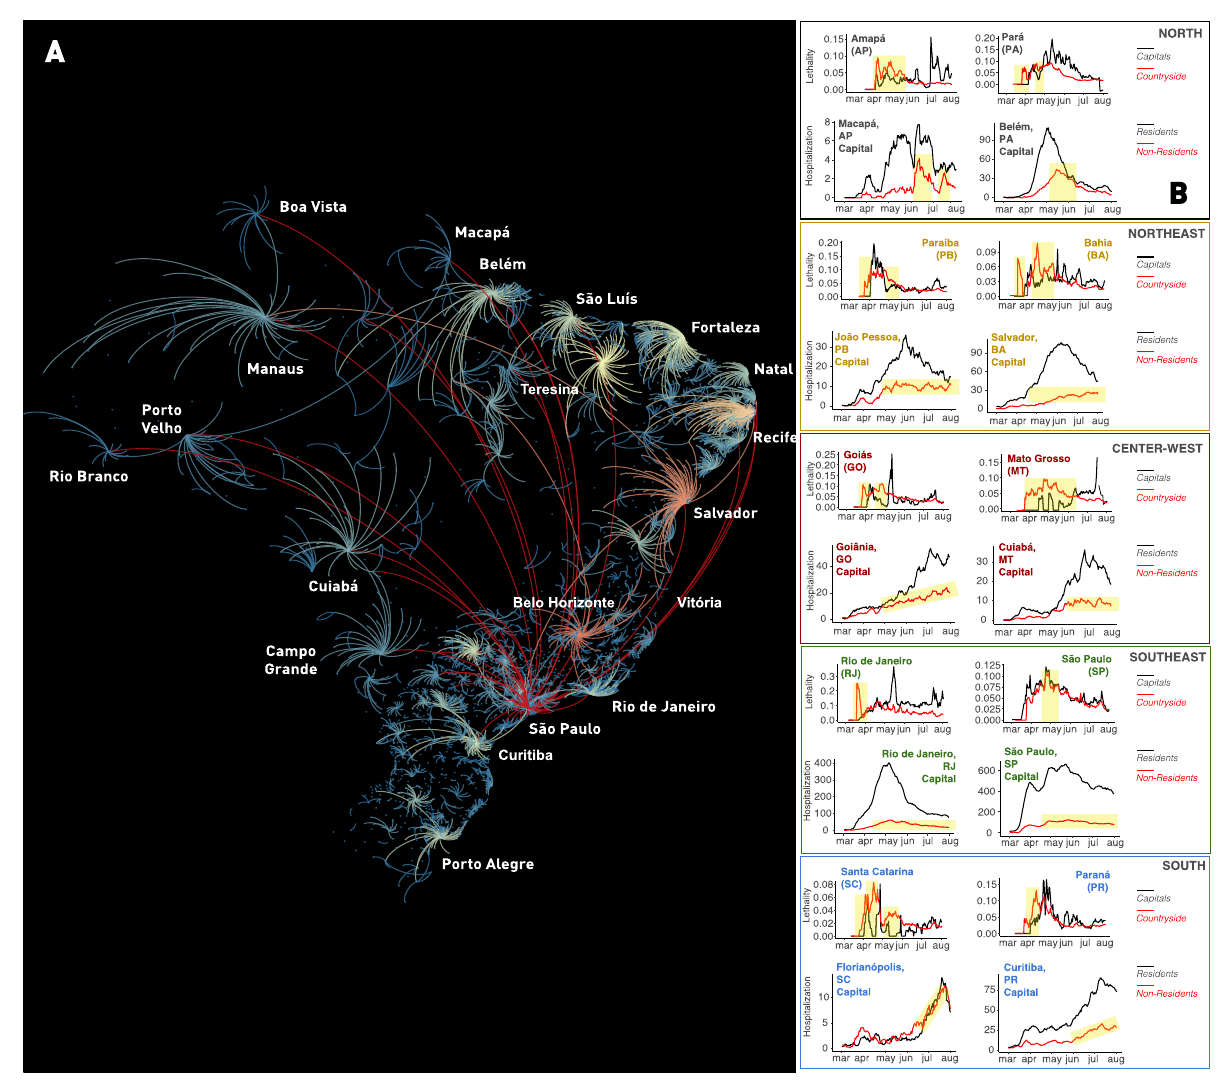
Figure 3. Quantification of the Brazilian “boomerang effect”. ( A ) Representation of all “boomerangs” that occurred around major Brazilian state capitals (see labels for names) and mid-size cities across the whole country. In this map, arcs represent the flow of people from the interior towards the capital. The arc color code represents the number of interior cities that sent severely ill patients to be admitted in hospitals in a capital or mid-size town; red being the highest number of locations, orange and yellow next, while a smaller number of locations are represented in light blue. Most of the flow of people represented in this graph took place through highways. Red arcs likely represent long-distance flow by airplanes. In the Amazon, most of the flow of people towards Manaus occurred by boats through the Amazon river and its tributaries. Notice that again São Paulo appears as the city with the highest boomerang effect, followed by Belo Horizonte, Recife, Salvador, Fortaleza, and Teresina. ( B ) Lethality and hospitalization data, divided for capital and interior (for lethality) and capital resident and non-resident (hospitalization), for a sample of state capitals in all five regions of Brazil. Yellow shading in the lethality graphs represent periods in which more deaths occurred in the interior, in relation to the capital. In the hospitalization graphs, yellow shading depicts periods of increasing admission of people residing in the countryside to the capital hospital system. The overall flow of people from capital to the interior and back to the capital characterized the boomerang effect, targeting the hospital system of the capital city. Notice that the boomerang effect was pervasive all over the country, occurring in every Brazilian state. Map generated using Gephi (https:// gephi. org/, see Bastian et al. 48